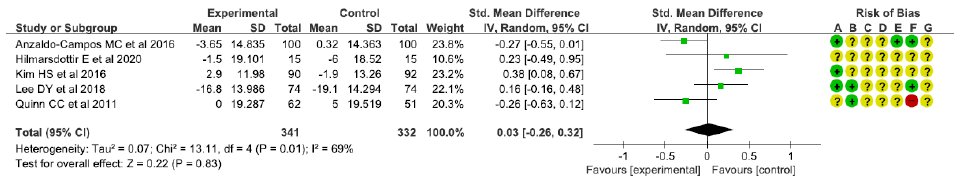
Figure 11. Forest plot for meta-analysis results on diastolic blood pressure. 4. Discussion T2DM is a chronic disease that requires continuous management of lifestyle with pharmacotherapy. However, current diabetes management services for poorly controlled T2DM patients have limitations to modify diabetes management lifestyle. Along with the development of IoT and 5G communication technology, attempts are continuously being made to use digital healthcare technology as a tool for chronic diseases care, with notable strength [7,22,23]. Digital healthcare technology is usually used to help patients enhance and sustain their healthy behaviors such as physical activity, medication adherence, nutrition intake, and stress management. For healthcare providers, it can increase opportunities to contact patients, thus enabling closer monitoring. In this study, we conducted a systematic review and meta-analysis to evaluate the clinical effects of counseling and intervention services by healthcare providers using